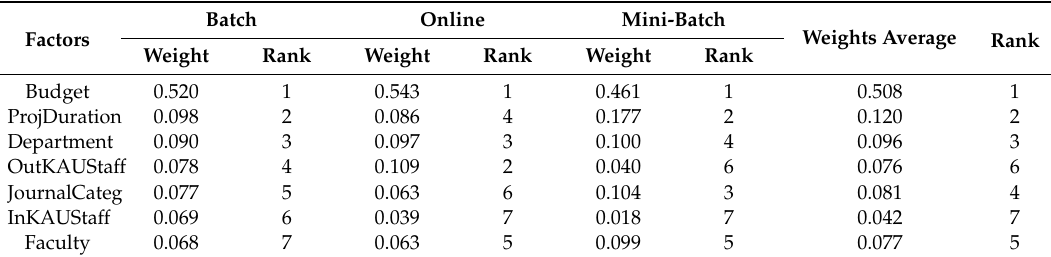
Table 6. Factors weights and rank according to training